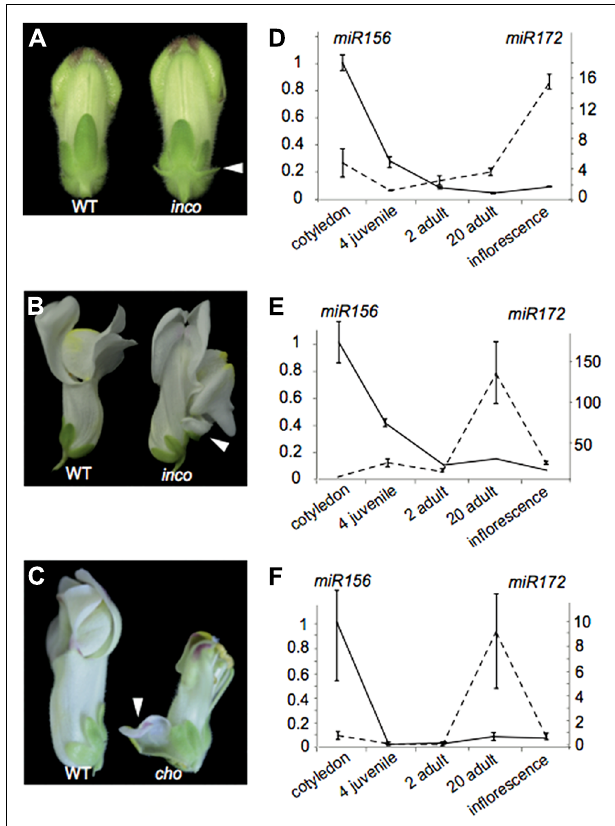
FIGURE 4 |The heterochronic Antirrhinum mutant choripetala . (A) In incomposita , prophylls develop which are absent in wild-type Antirrhinum flowers. (B) Inco also occasionally develops petaloid sepals. (C) Petaloid sepals and an unfused corolla can also be observed in choripetala . (D) The expression pattern of miR156 (left axis) and miR172 (right axis) in Antirrhinum is similar to what has been observed for wild-type Arabidopsis and other species. Both in inco (E) and in cho (F) , an early increase in miR172 can be observed late in adult development and lower expression levels are present in inflorescence tissue. Error bars represent standard errors of three technical replicates. A second biological replicate gave similar